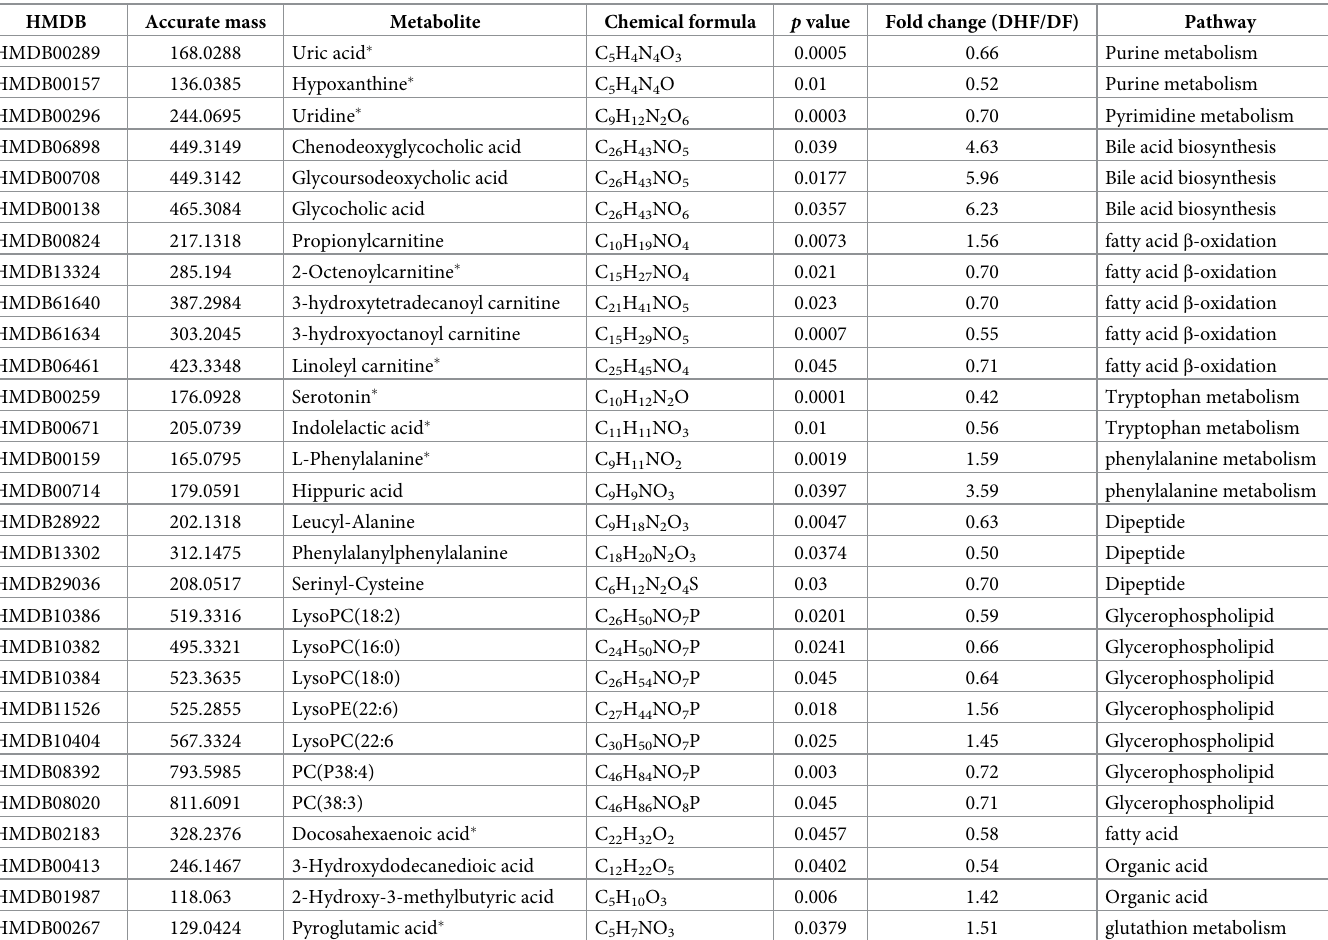
Table 1. Identified differentially expressed metabolites between dengue fever (DF) and dengue hemorrhagic fever (DHF) patients in the critical phase of infection.